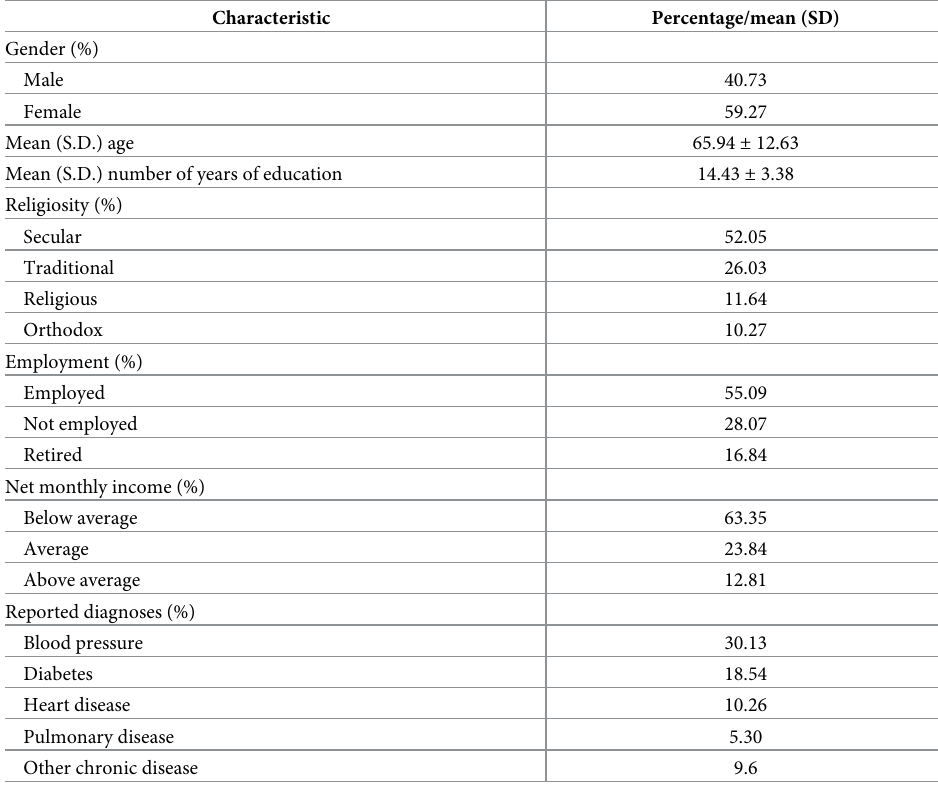
Table 1. Participants’ characteristics (n =